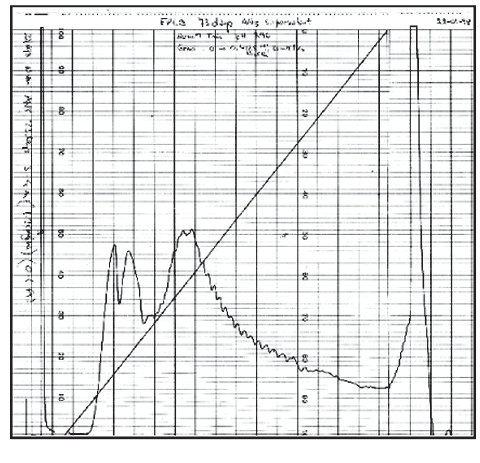
Figure 3. SDS-PAGE analysis of the anion-exchange chromatog- raphy elution profile of 38-day AN5 culture supernatants. The fraction number is indicated above each lane. AN5 = culture supernatants before chroma- tography. Note the relatively large amounts of low MW pro- teins in fractions 30 to 35. Num- bers on the left indicate the molecular mass